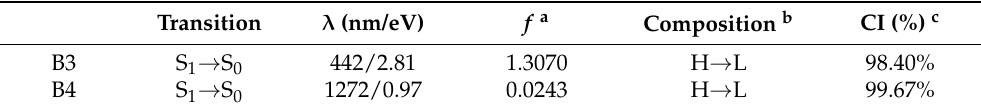
Table 4. B3LYP − D3/TZVP/IEFPCM levels calculated emission energies (nm), corresponding oscillator intensities and corresponding compositions for the B3 and B4 compounds.